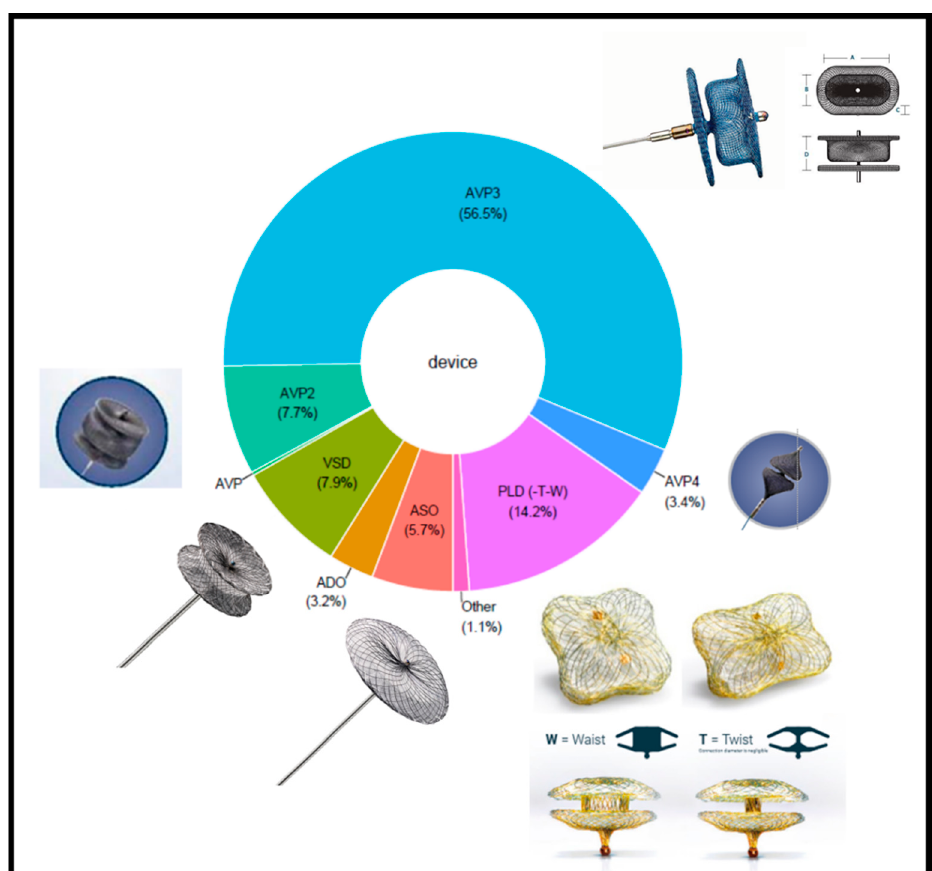
Figure 2. The distribution of devices in the three registries. ADO: Amplatzer Duct Occluder; ASO: Amplatzer Septal Occluder; AVP: Amplatzer Vascular Plug; AVP 3: Amplatzer Paravalvular leak plug 3; PLD: Paravalvular Leak Device (Occlutech); VSD: Ventricular Septal Defect.